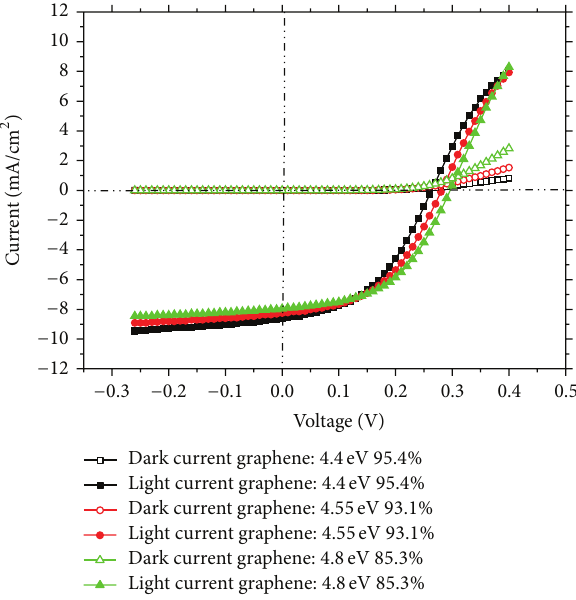
Figure 6: Current-voltage curves of graphene solar cells versus different graphene work function.